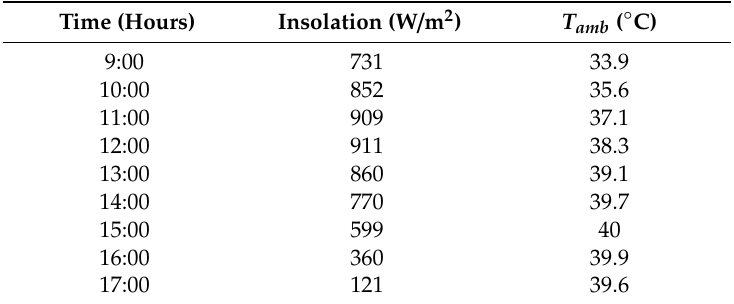
Table 6. Solar insolation and ambient temperatures used for the parametric study. Time (Hours) Insolation (W / m 2